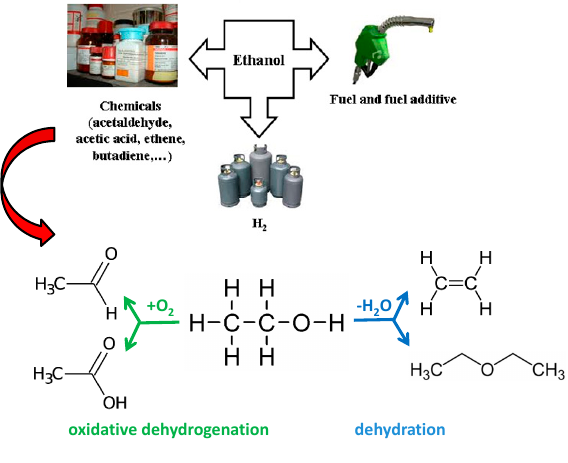
Figure 1. Possible uses of ethanol.